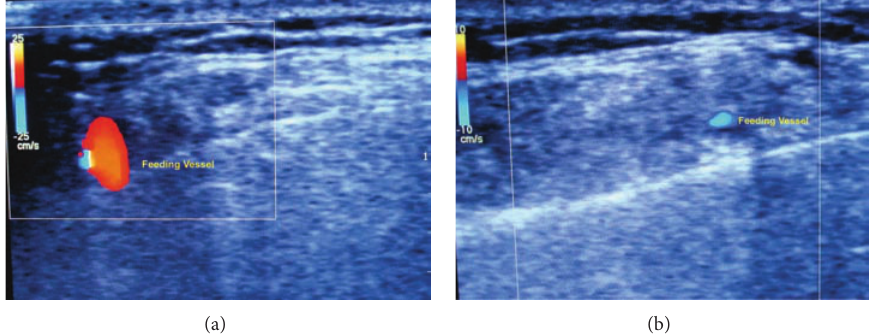
Figure 3: (a, b) Colour Doppler sonography showing internal vascularity.